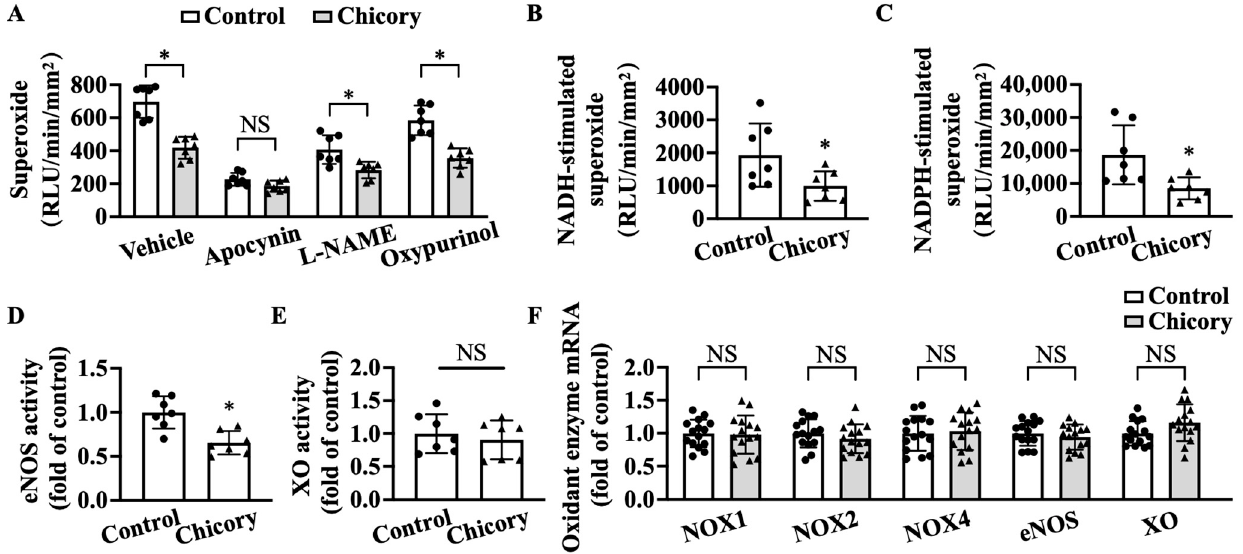
Figure 5. Brussels chicory alleviates NADPH oxidase (NOX)- and uncoupled endothelial nitric oxide synthase (eNOS)-mediated free radical production in the aortas of Apoe − / − mice. ( A ) Thoracic and abdominal aortic superoxide production in the presence or absence of either apocynin, N ω - nitro-L-arginine methyl ester (L-NAME) or oxypurinol (n = 7). ( B , C ) NADH-stimulated ( B ) and NADPH-stimulated ( C ) superoxide levels in thoracic and abdominal aortas (n = 7). ( D , E ) Relative eNOS ( D ) and XO ( E ) activities in the thoracic and abdominal aortas (n = 7). ( F ) Relative NADPH oxidases, eNOS, and XO expression in the aortic arches at the mRNA level measured by qRT-PCR ( n = 15). Data are presented as means ± SD. * Significantly different from the control group ( p < 0.05). Scale bars: 100 μ m. Apoe, apolipoprotein E; Chicory, Brussels chicory.